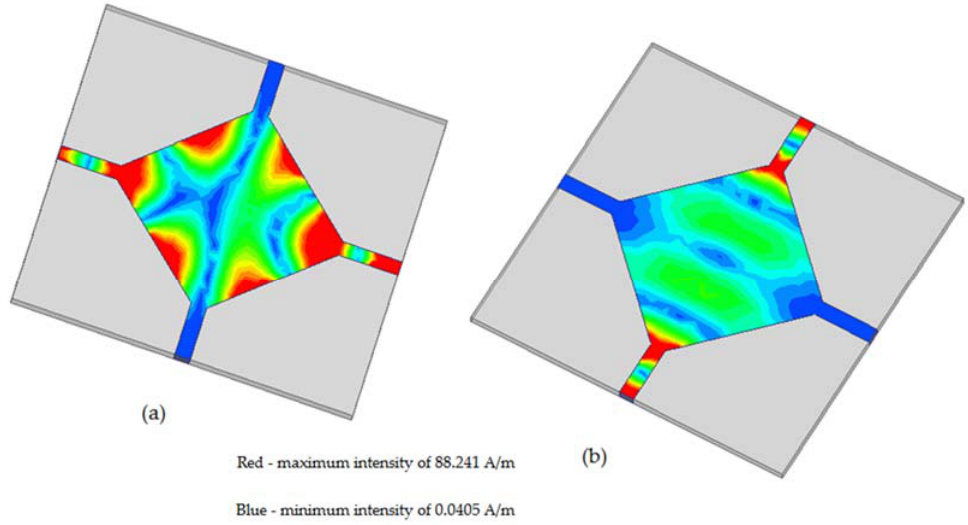
Figure 9. Current distribution of Diamond Patch Crossover; ( a ) at 2.43 GHz; ( b ) at 5.2 GHz.